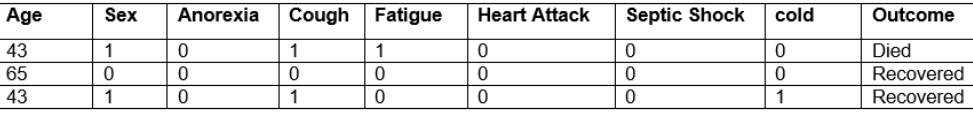
Figure 2. Sample of the tabular dataset.